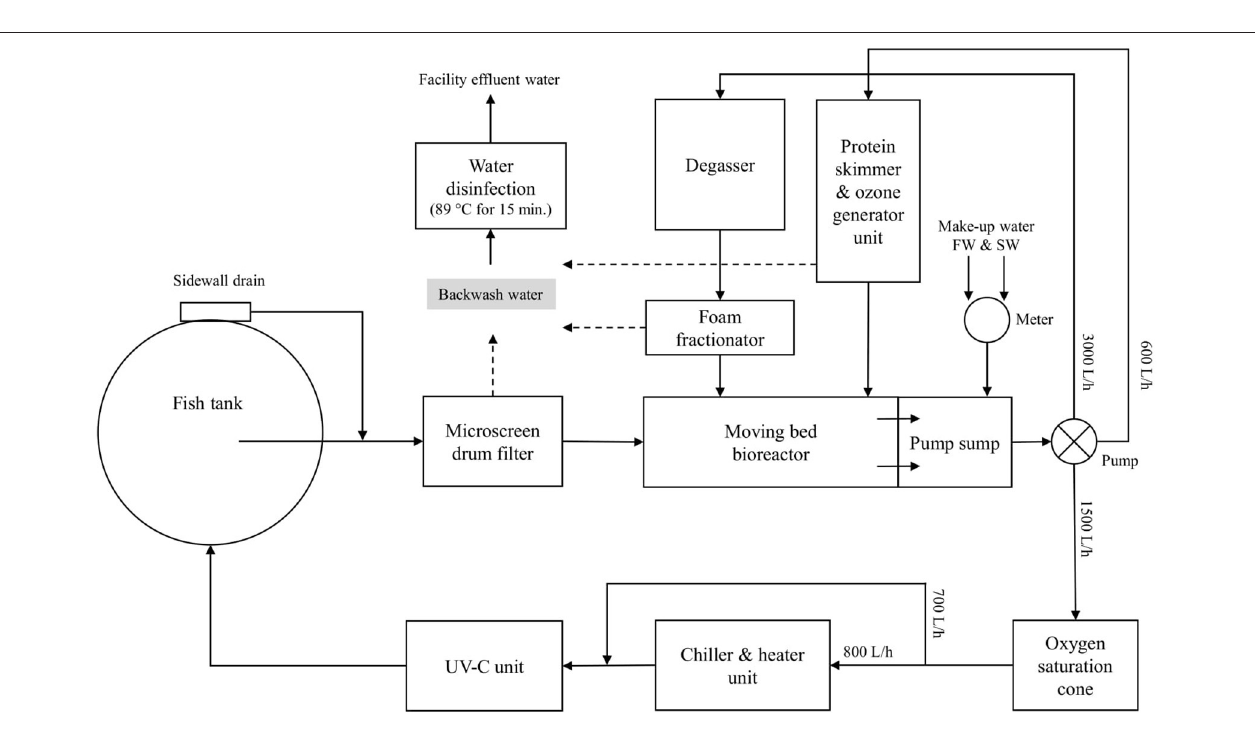
of the fish tank via a bottom center outlet and a sidewall outlet into a microscreen drum filter with a 40- µ m screen to remove suspended solids. The backwash discharged from the microscreen is piped to a septic tank and to an underground pipe circuit (500 m long) where water is heated and disinfected (89 ◦ C for 15 min.). The microscreen drum filtrate flows into the moving bed bioreactor (MBBR, V = 0.2 m 3 , 50%